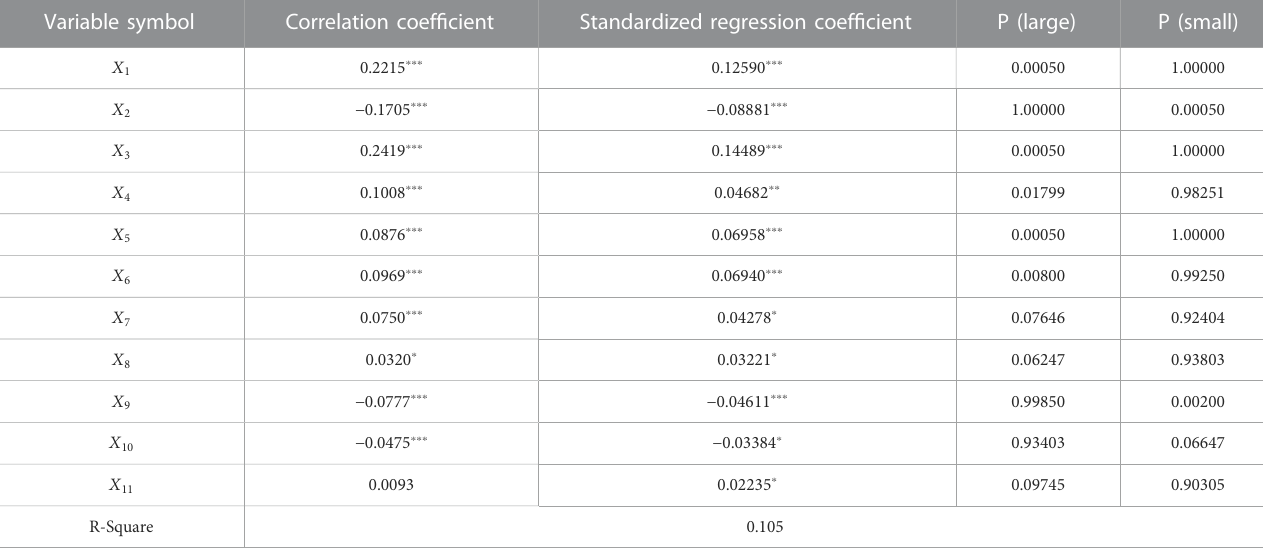
TABLE 5 Analysis results of QAP correlation and regression. Variable